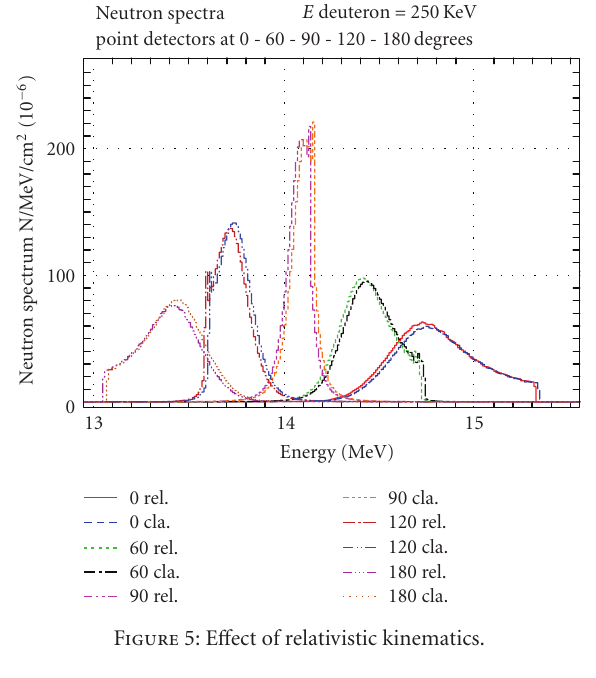
Figure 5: E ff ect of relativistic kinematics.